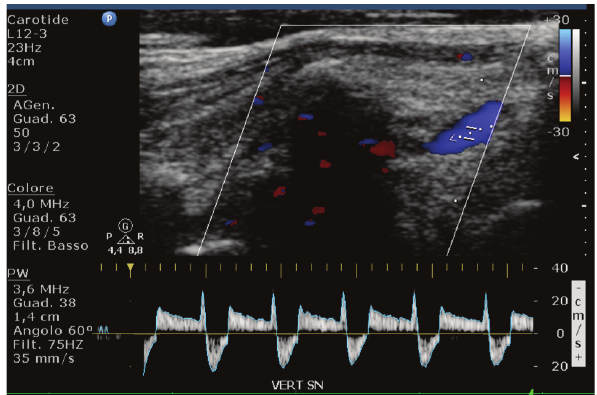
Figure 1: Color-Doppler-Ultra-Sonography spectral images obtained after the patient exercised the left arm (by opening and closing the hand for two minutes): mid-systolic deceleration with retrograde late-systolic velocities.